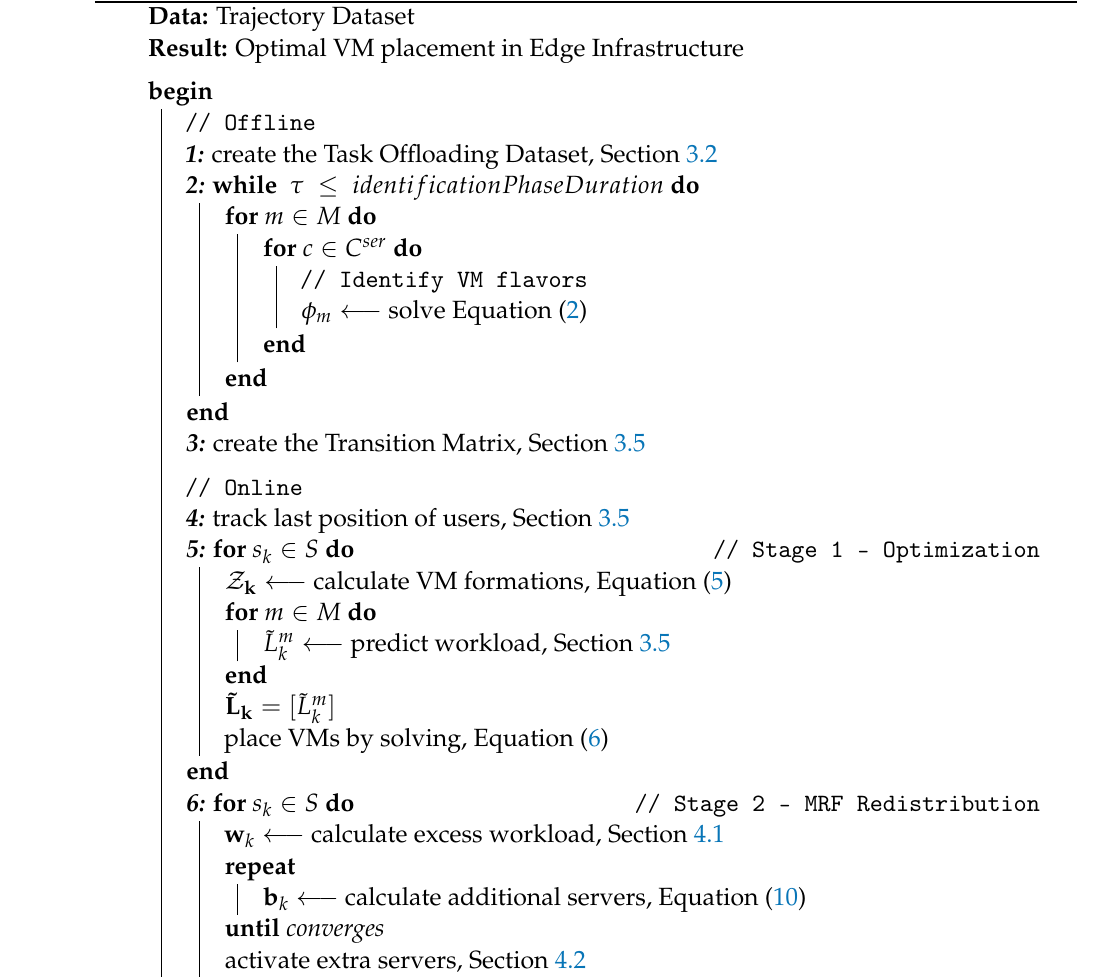
Algorithm 1: ENERDGE core